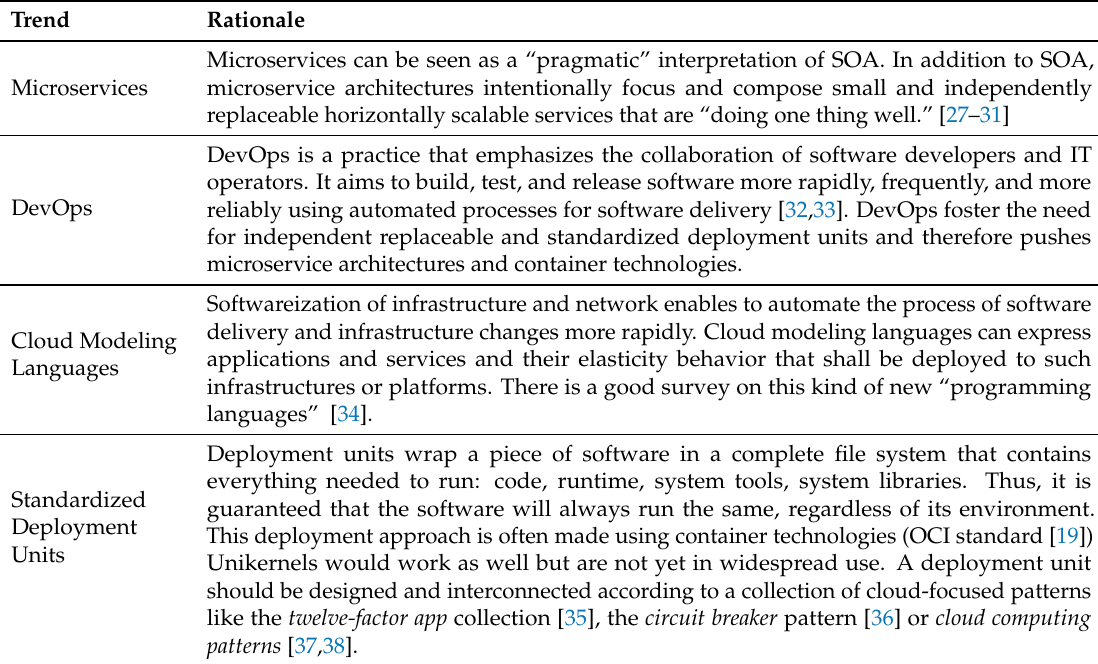
Table 2. Some observable software engineering trends coming along with cloud-native applications. Trend Rationale